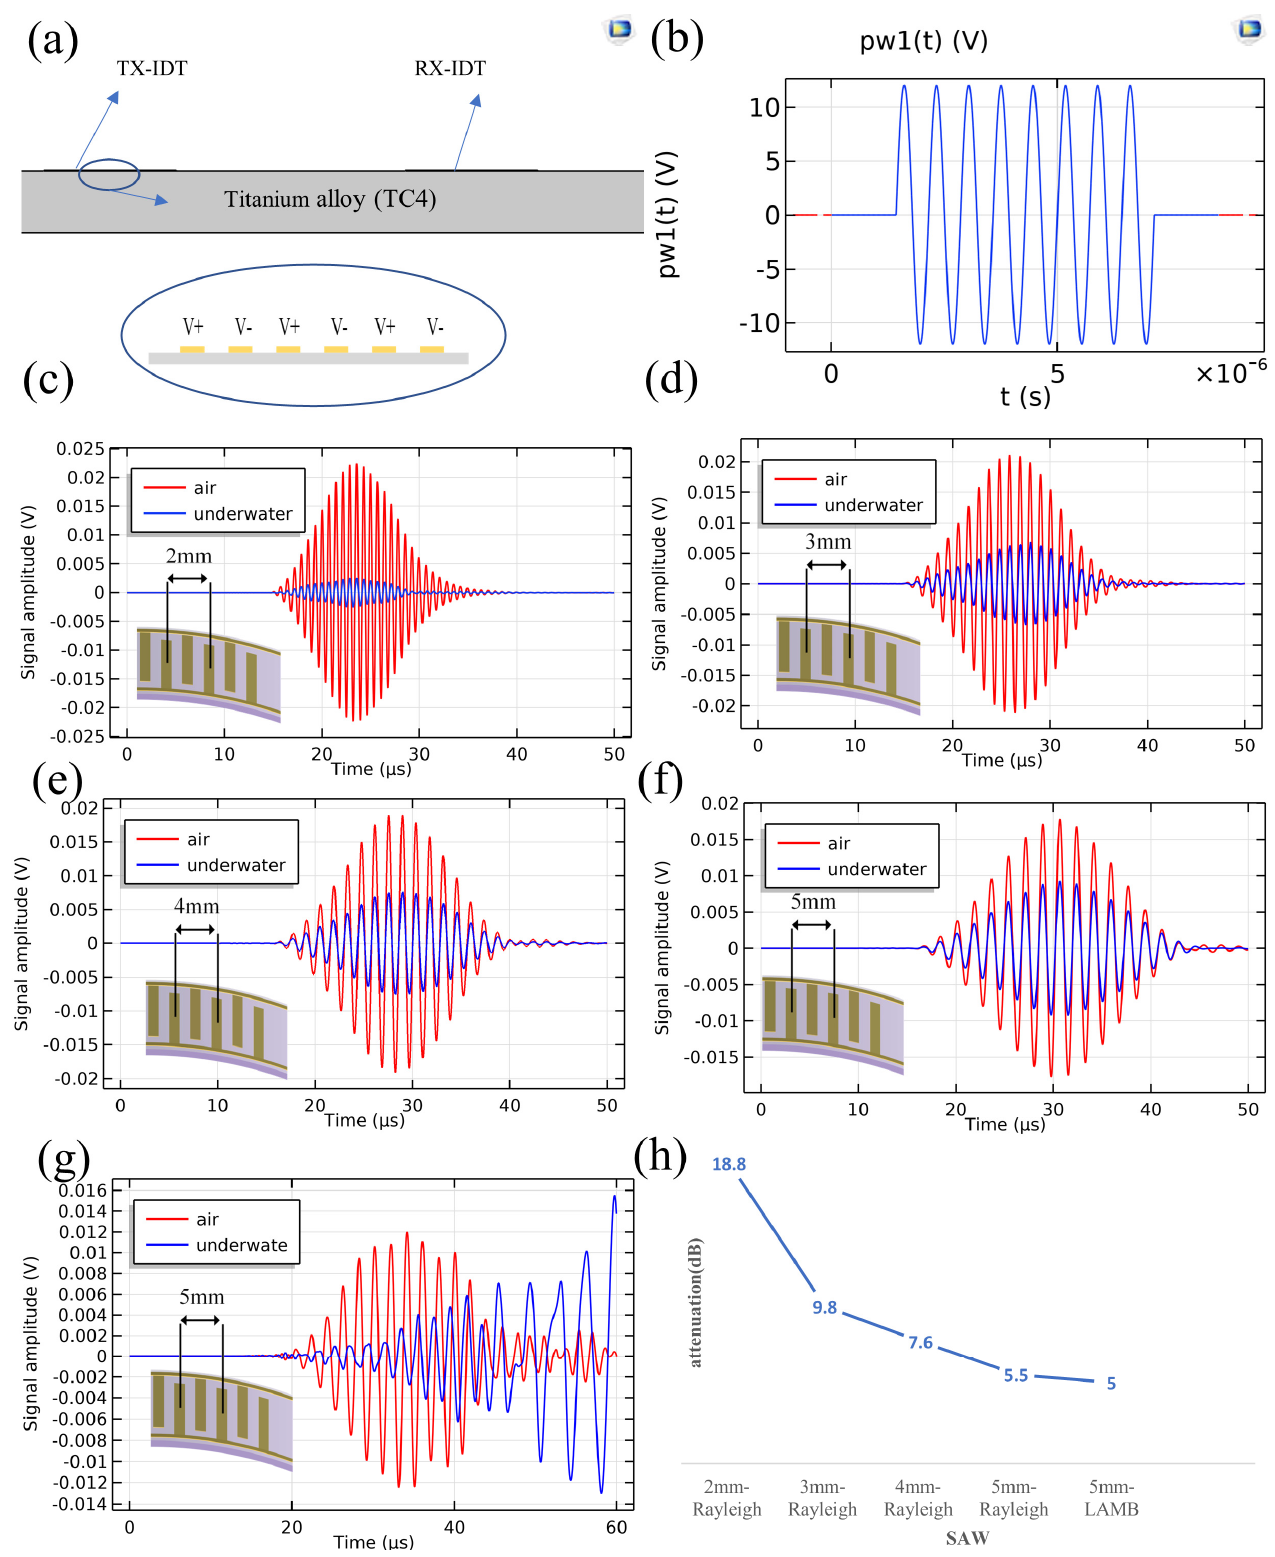
Figure 2. ( a ) Simulation model of IDT. ( b ) IDT excitation signal. ( c ) Simulation results of Rayleigh wave with 2 mm wavelength. ( d ) Simulation results of Rayleigh wave with 3 mm wavelength. ( e ) Simulation results of Rayleigh wave with 4 mm wavelength. ( f ) Simulation results of Rayleigh wave with 5 mm wavelength. ( g ) Simulation results of Lamb wave with 5 mm wavelength. ( h ) Underwater wave attenuation with geometries of transducer.